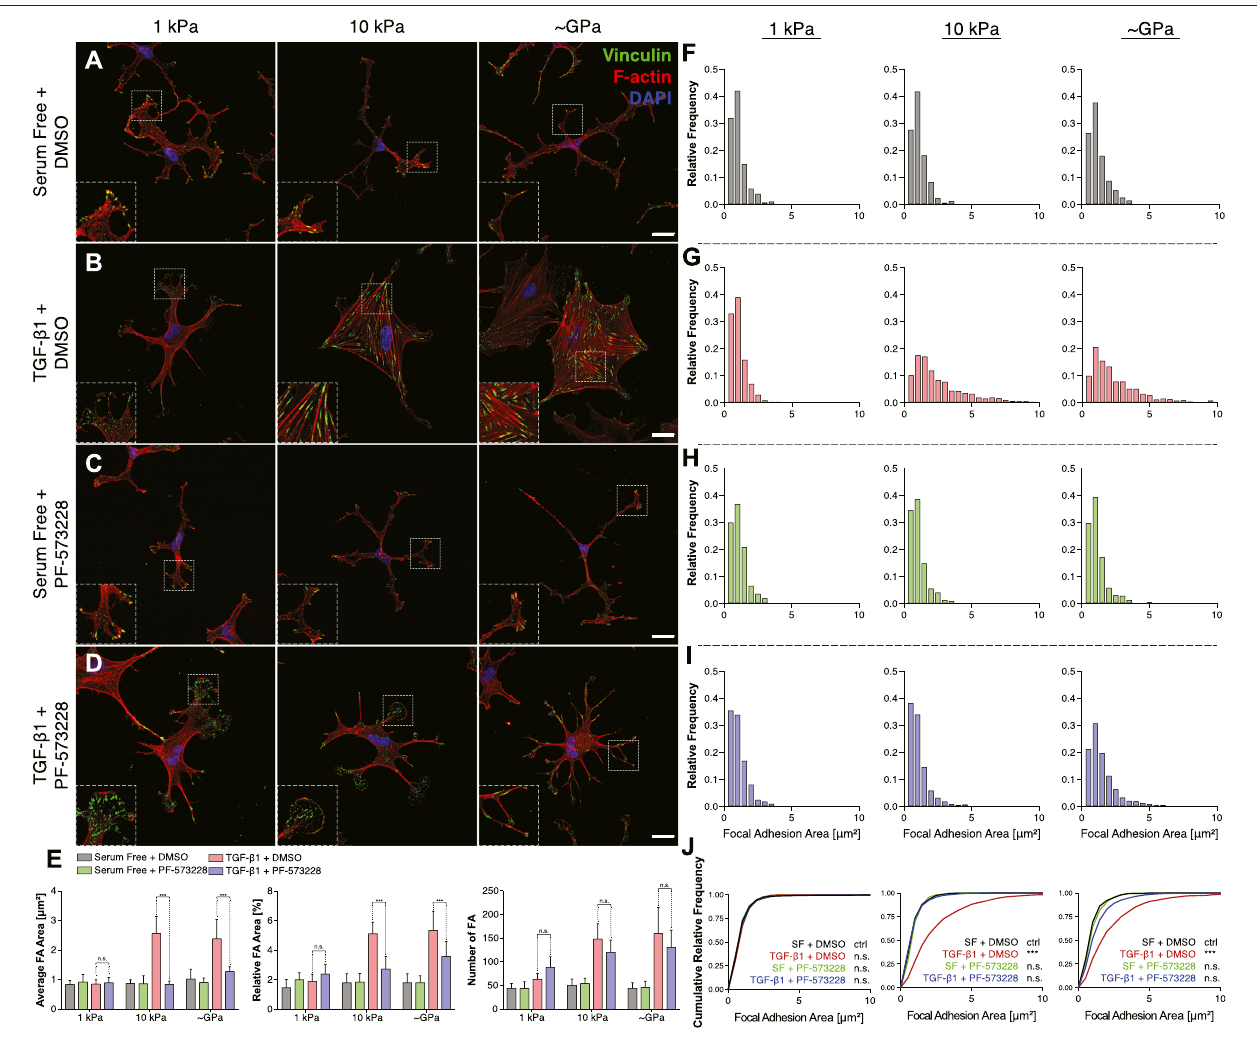
FIGURE 7| Inhibition of FAKalters subcellular distributions ofFAs on stiff substrata in the presence of TGF- β 1. (A – D) Characteristic confocal fl uorescence images of primary corneal keratocytes cultured on either soft or stiff PA gels (left or middle columns, respectively), or on collagen coated glass coverslips (right column). Cells wereculturedfor5 daysineitherserum-freeconditions (A,C) orinmediumcontainingexogenousTGF- β 1 (B,D) ,andineitherthepresence (C,D) orabsence (A,B) ofthe FAK inhibitor, PF-573228. Cells were stained for vinculin immuno fl uorescence (green), as well as F-actin (red) and DAPI (blue). Scale bars, 25 μ m. Dashed white lines indicate insets. (E) Quanti fi cation of the average area (left), relative area (middle), and number (right) of focal adhesions (FAs) in individual cells. Error bars represent mean±s.d.for n =8substratesfrom4experimentalreplicates.Atwo-wayANOVAwithaTukeypost-hoctestwasusedtoevaluatesigni fi canceamonggroups.(***, p < 0.001) (F – I) Relative frequency histograms of FA size in cells cultured in either the presence (H,I) or absence (F – G) of PF-573228. (J) Cumulative frequency plots of FA size. A Kolmogorov-Smirnov test was used to evaluate signi fi cance between groups.